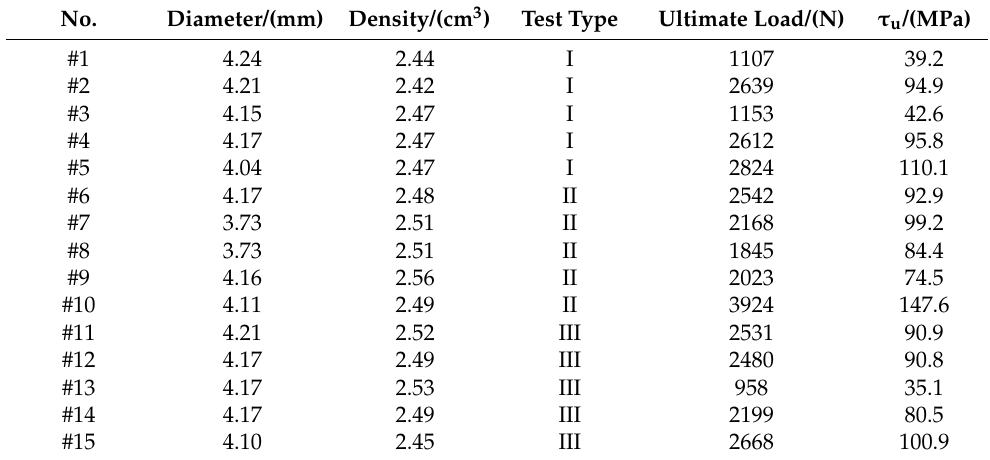
Table 3. Double-shear mechanical properties of the 12k T-700 TM MWK–N–C/SiC pins. No. Diameter/(mm) Density/(cm 3